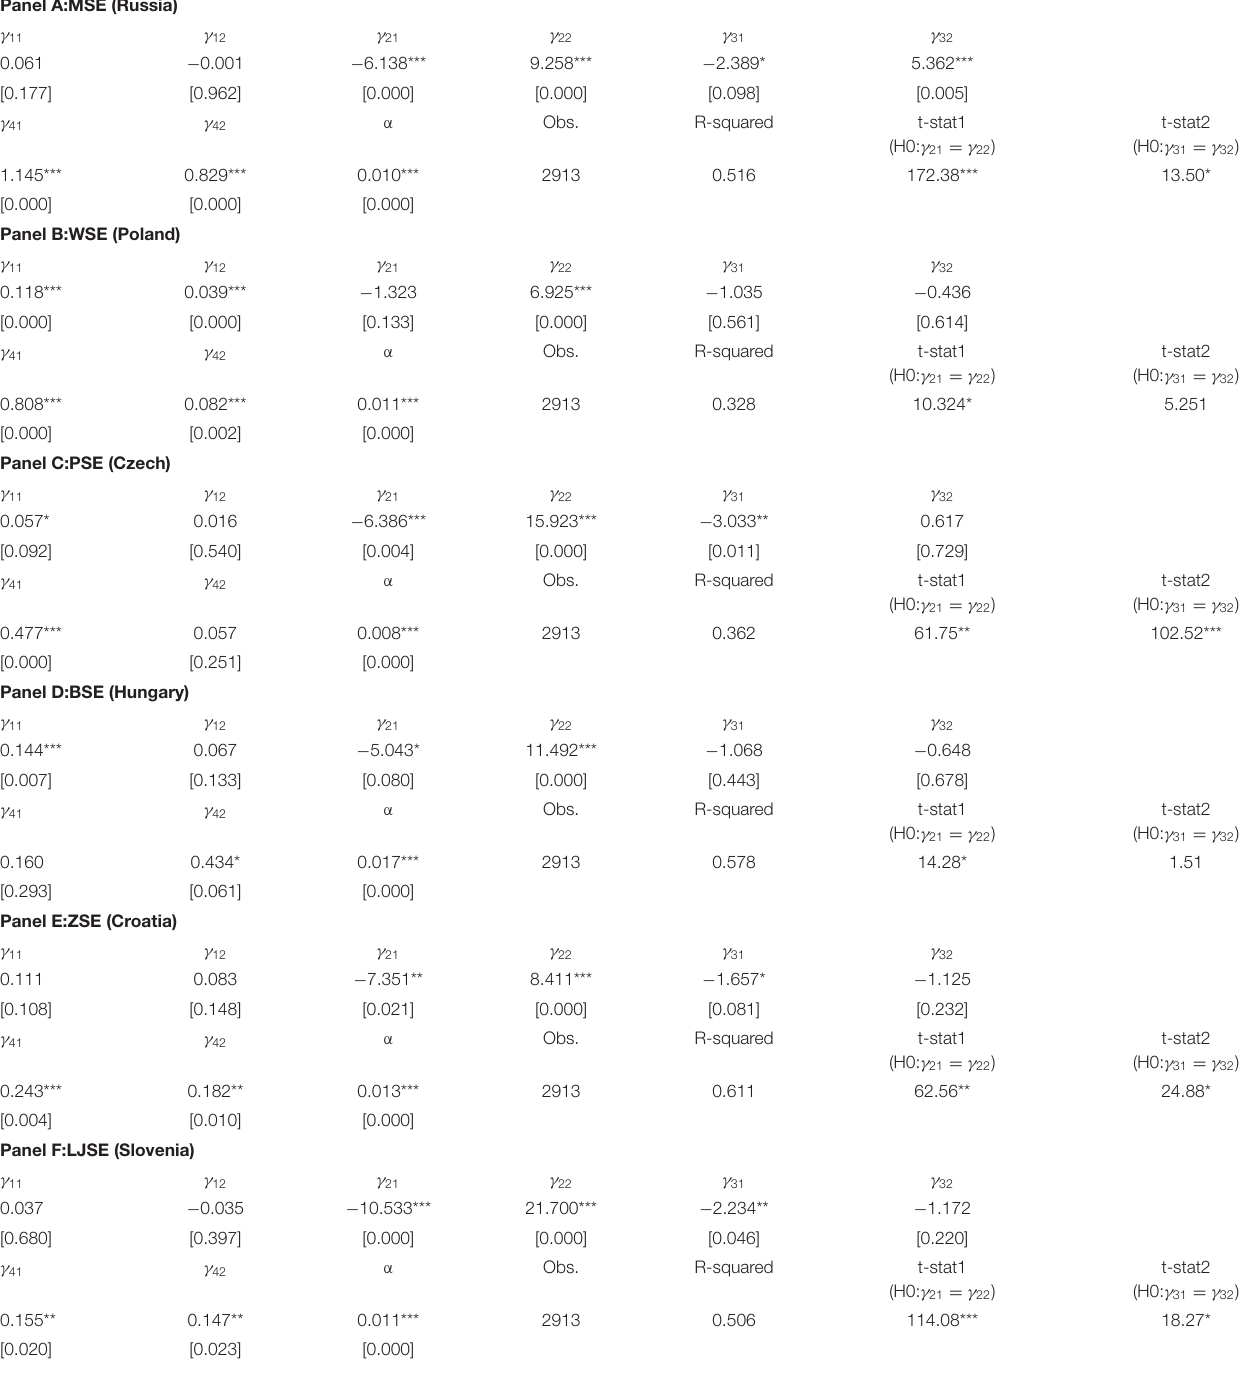
TABLE 3 | Effect of COVID-19 on herding behaviour in Eastern Europe markets for the general model. Panel A:MSE